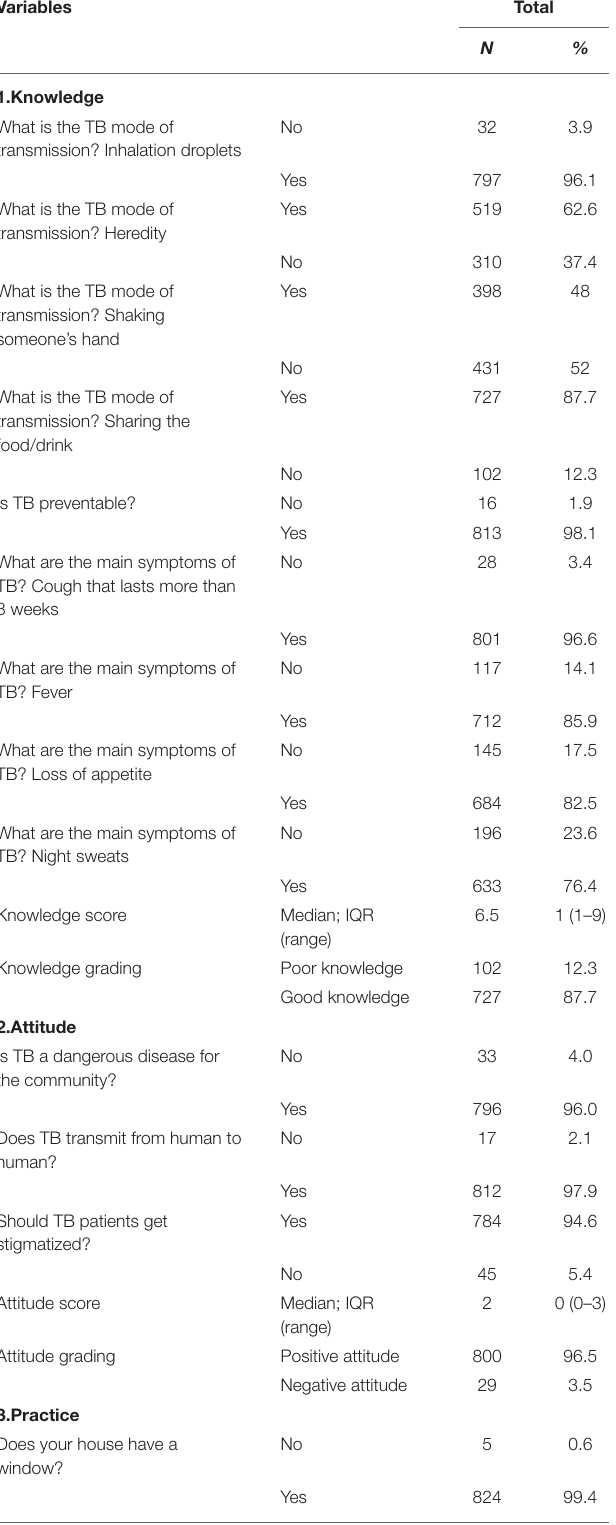
TABLE 2 | Knowledge, attitude, and practices toward tuberculosis among hospital outpatients in Kabul, Afghanistan ( N = 829 ). Variables